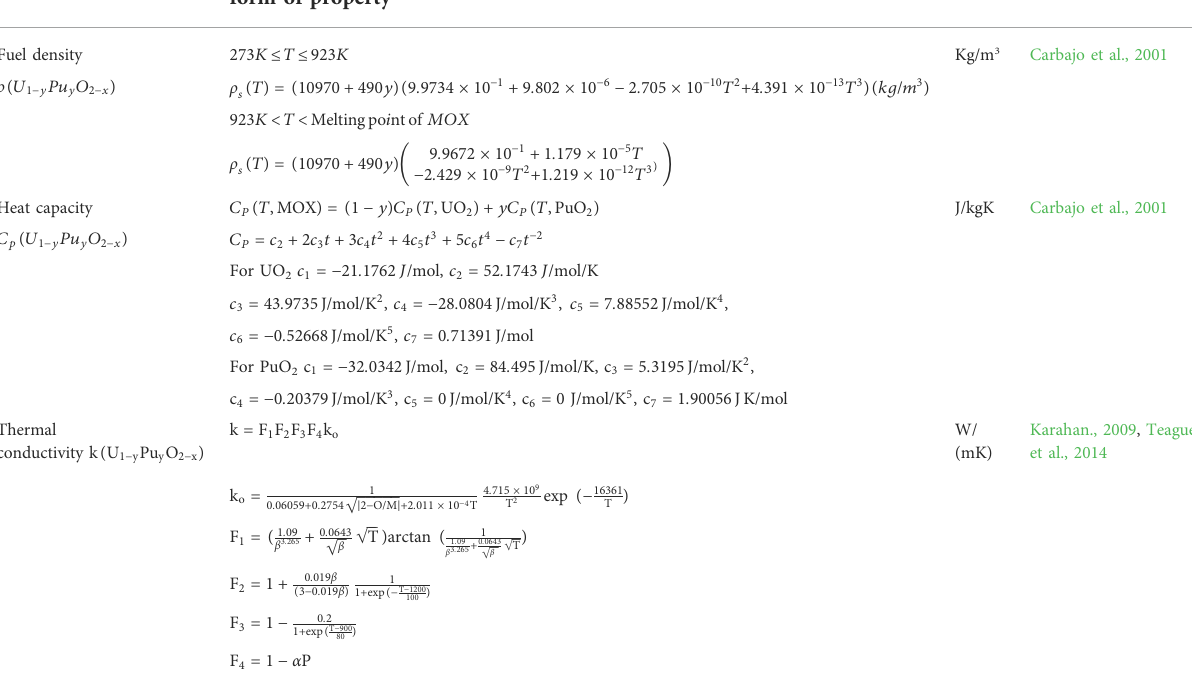
TABLE A1 Summary of MOX U 1 − y Pu y O 2 − x fuel property Property Functional form of property